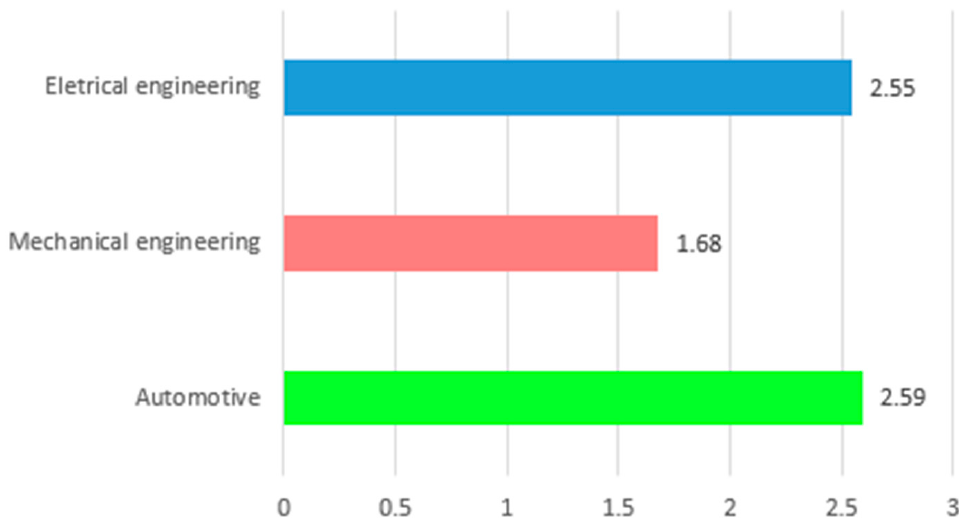
Figure 16. Comparison of average values of dimensions according to industry.